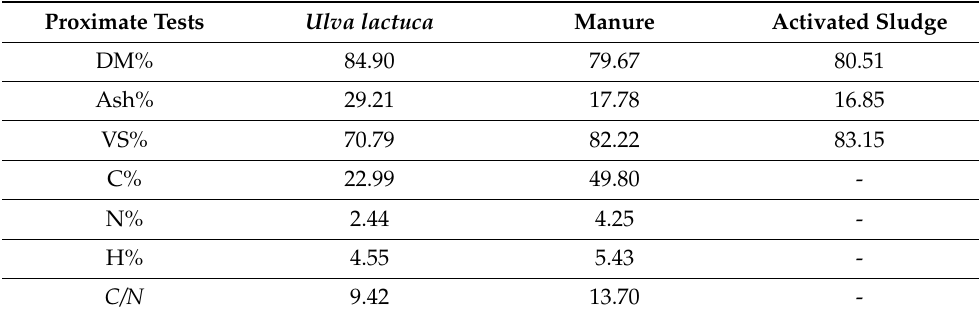
Table 2. The proximate values of different substrates.